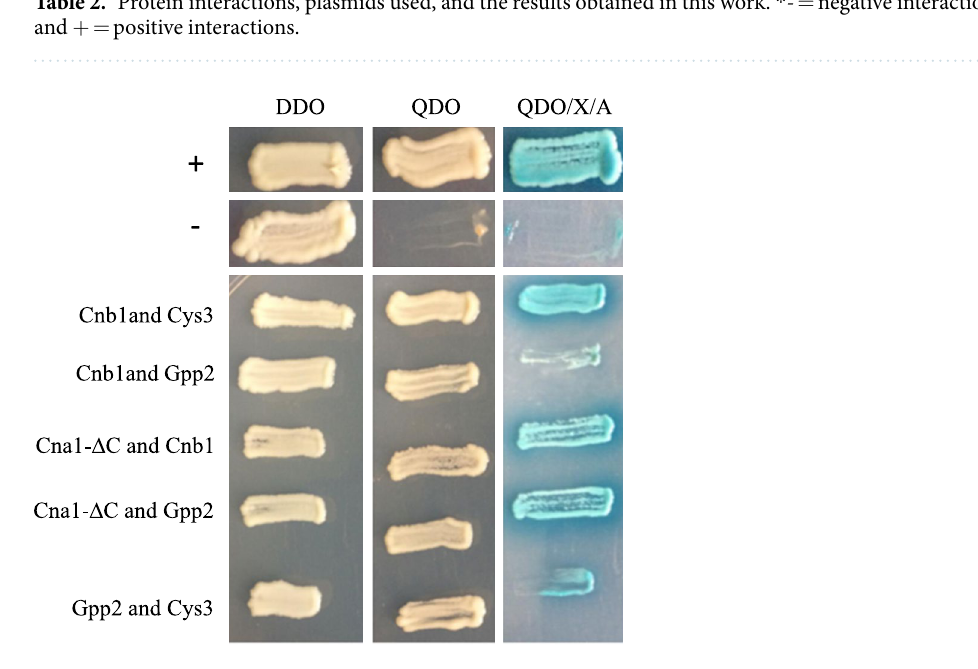
Figure 6. Yeast two-hybrid assay. Images depict representative colonies of S . cerevisiae expressing pairs of bait and prey fusion proteins, which are described at the left side of the panel. Each column represents a plate composition; DDO = double drop out (minus tryptophan and leucine), where no reporter gene is activated; QDO = quadruple drop out (minus tryptophan, leucine, histidine, and adenine), where two reporters are activated; and QDO/X/A = quadruple drop out with aurobasidin and X- α -Gal, where all four reporters are active. + represents the positive and − the negative control provided by Match Maker kit